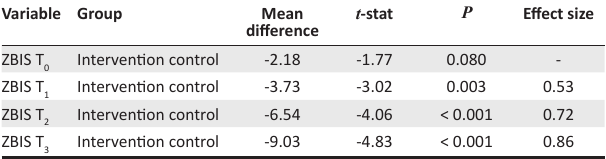
TABLE 2: Comparison of the effect of the intervention on caregiver and patient variables across intervals of follow-up.